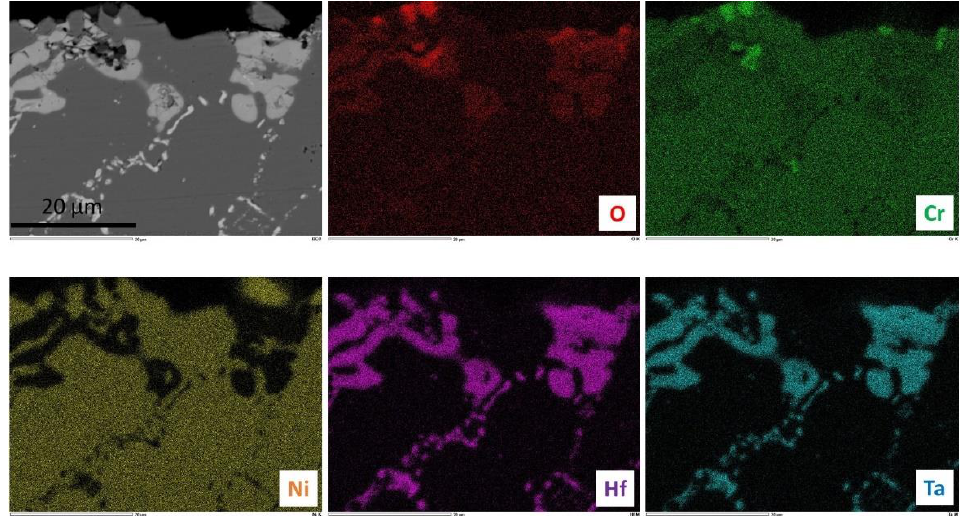
Figure 12. X-maps showing the elemental repartition in the subsurface of the oxidized H alloy. Concentration profiles were acquired across these sub-surfacic zones affected by ox- idation. Two examples of the obtained profiles are presented in Figure 13, one per alloy.